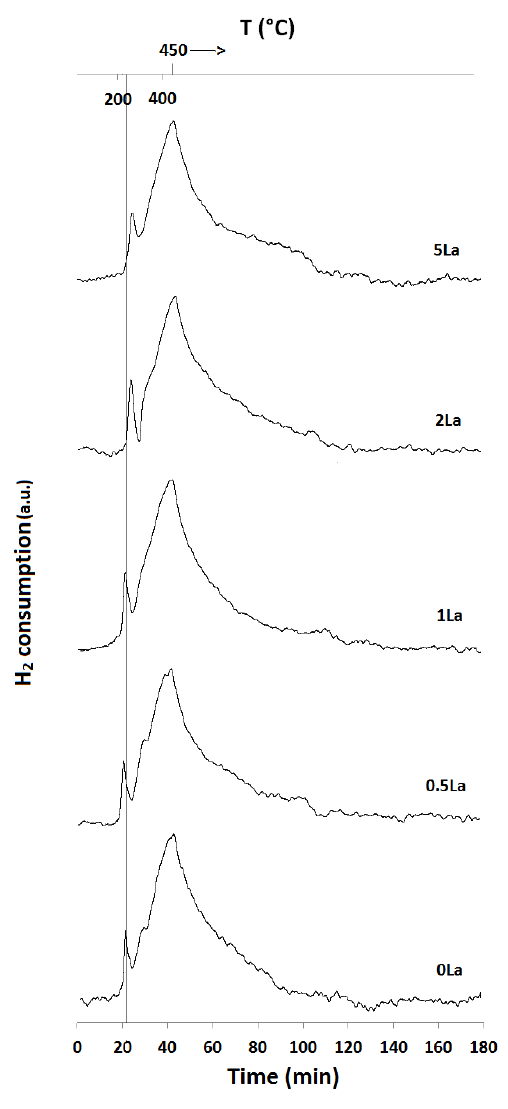
Figure 1. First temperature-programmed reduction profiles of all the catalysts (TPR 1, 10 mol % H 2 /Ar, total flow = 50 sccm, ramp rate = 10 °C/min). 0.5La catalyst starts reducing at the lowest temperature.